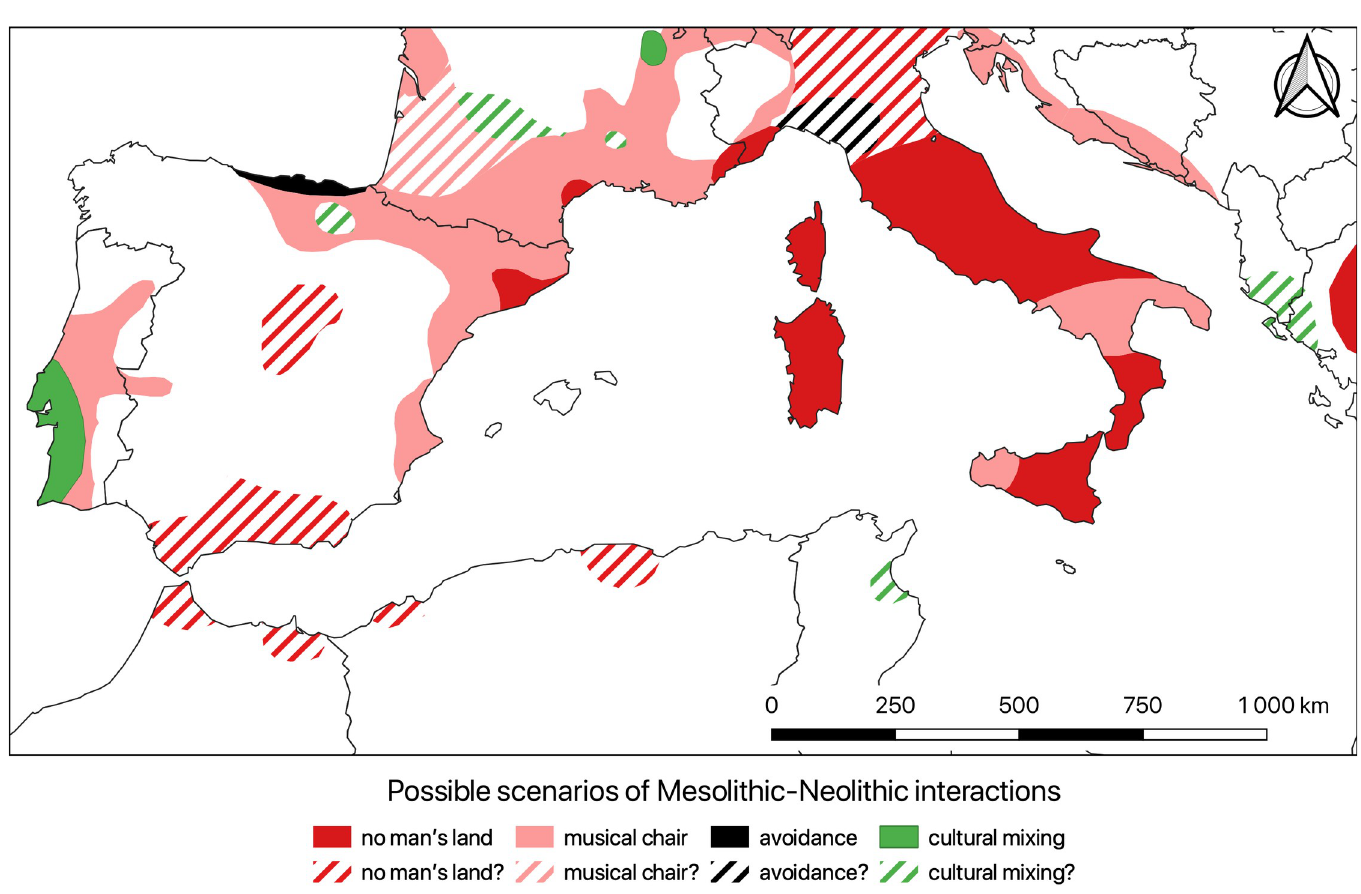
Fig 7. Different possible interaction scenarios between Mesolithic and Neolithic. Schematic map of the different possible interaction scenarios between Mesolithic and Neolithic groups during the Neolithization process in the Western Mediterranean, according to the currently available data. Countries boundaries are from Natural Earth (free vector and raster map data @